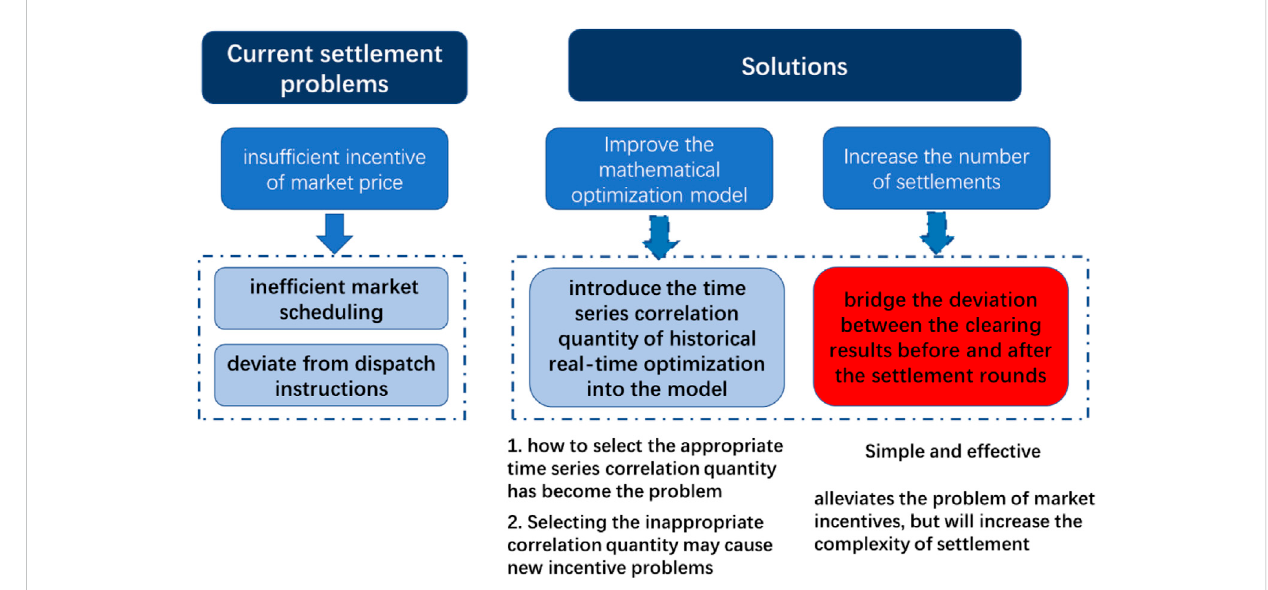
FIGURE 1 Overview of the